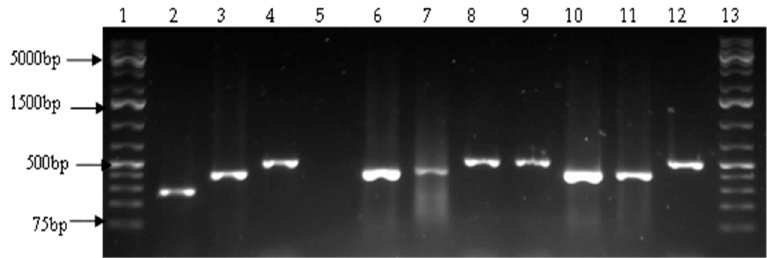
Figure 2. A representative agarose gel showing the 275 bp, 366 bp and 503 bp PCR products of V. cholerae toxR , V. vulnificus vvhA and V. parahaemolyticus toxR genes respectively. Lanes 1 and 13: molecular weight markers (1 kb plus), Lane 2: V. cholerae positive control (O139 positive DNA from CSIR, SA ) , lane 3: V. vulnificus positive control (ATCC 27562), lane 4: V. parahaemolyticus positive control (ATCC 17802), Lane 5: negative control, Lanes 6, 7, 10 and 11: V. vulnificus positive isolates, and lanes 8, 9 and 12: V. parahaemolyticus positive isolates.